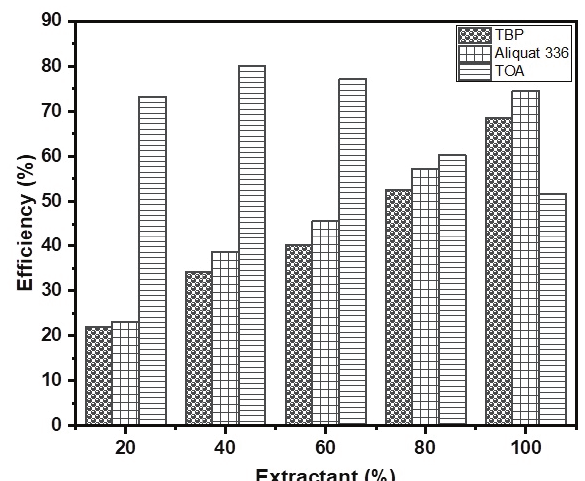
Fig. 2 – Equilibrium concentration of levulinic acid (LA) transferred in organic phase using TBP, Aliquat 336, and TOA with i-octanol using initial acid concentration of 0.441 mol kg –1